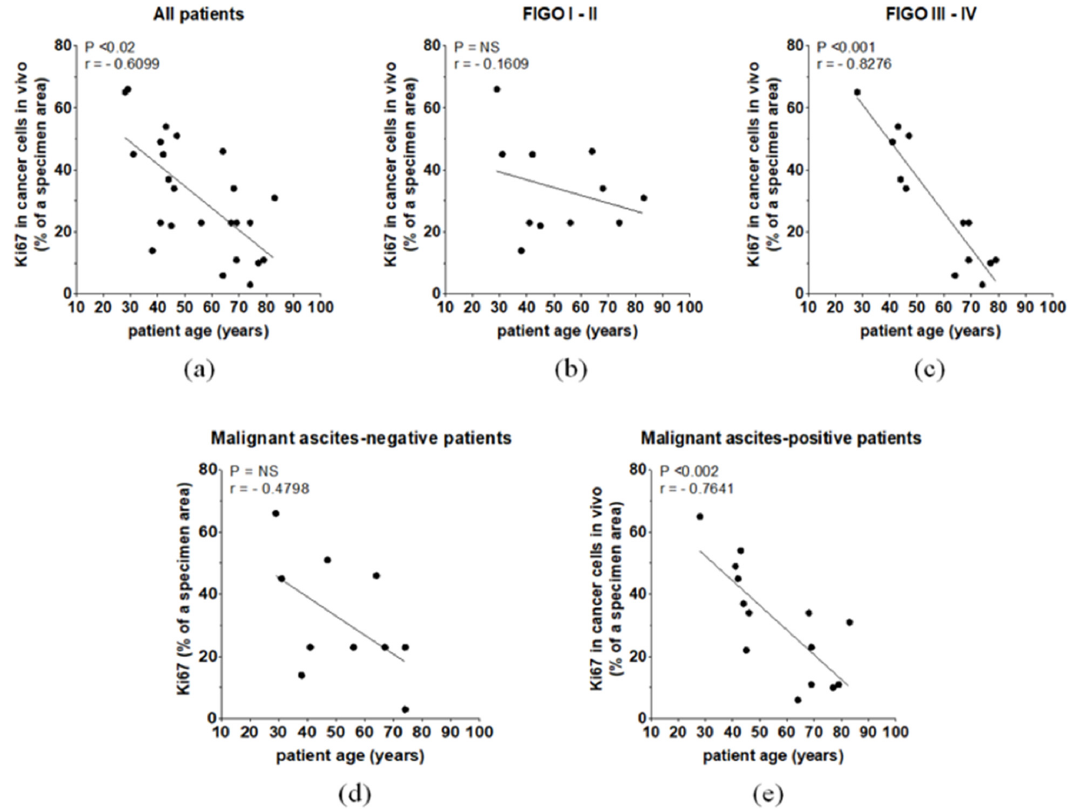
Figure 7. The relationships between ovarian patient age and Ki67 level in the whole cohort ( a ), patients with different FIGO stages ( b , c ), and patients with different malignant ascites statuses ( d , e ).